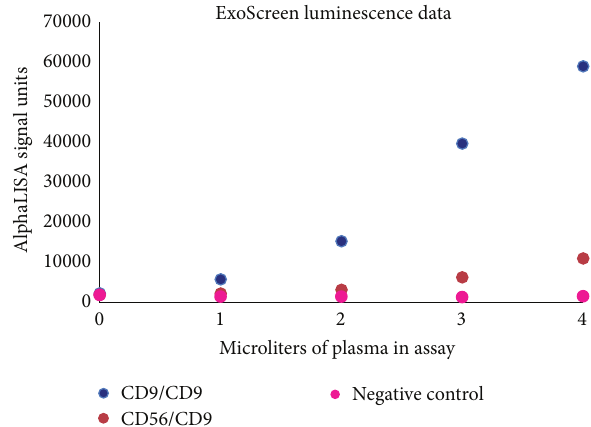
Figure 3: ExoScreen luminescent nsEV quantification assay data for various combinations of AlphaLISA donor and acceptor beads. Data show that ExoScreen allows quantification of neuronal exosomes in plasma. The 𝑦 -axis denotes AlphaLISA luminescence units. The 𝑥 -axis denotes microliters of plasma added to assay. CD9/CD9 donor/acceptor AlphaLISA luminescence data points represent averages of two measurements; values varied by less than 10% across duplicate measurements. Data points for CD56/CD9 and negative control Ab/negative control Ab bead combinations correspond to single